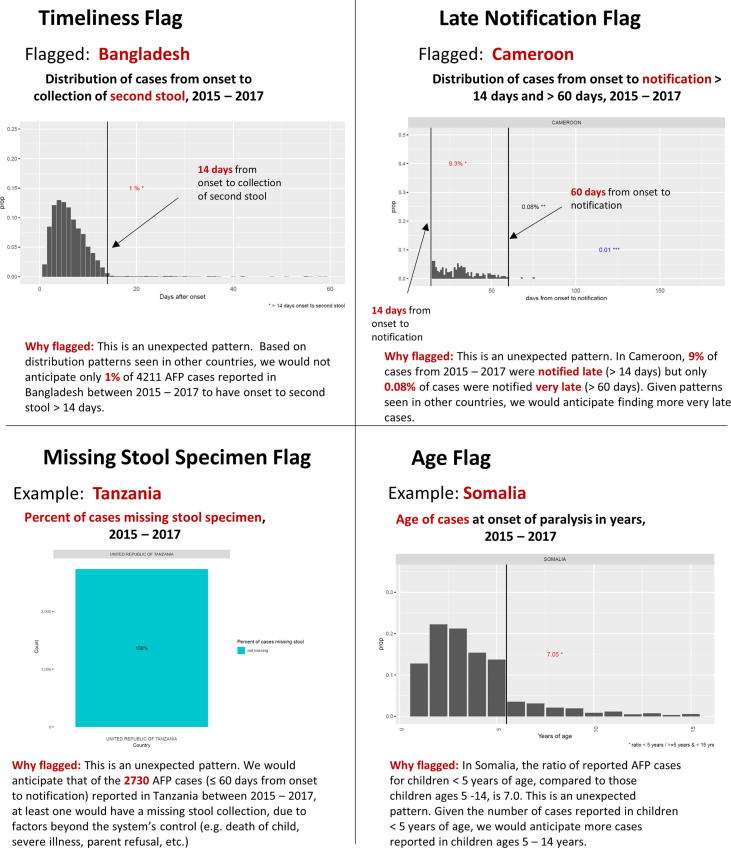
Example of Standardized Data visualizations for Four Surveillance Flags, 2015 – 2017.